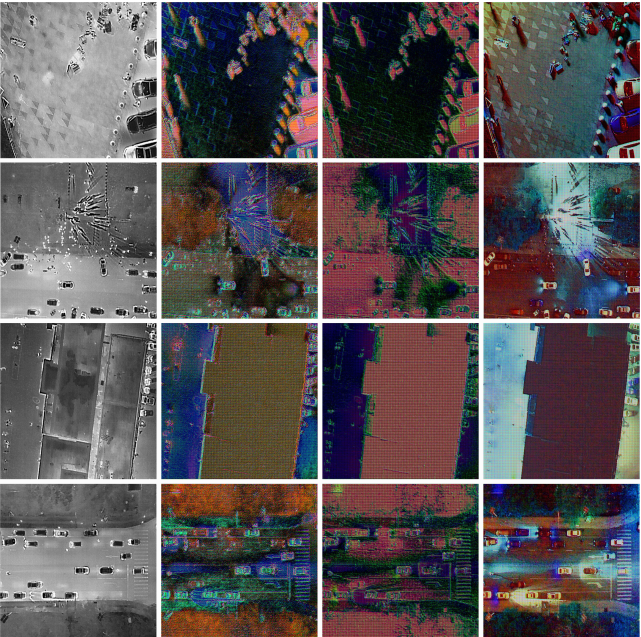
Figure 10. Samples of the four GAN models. From left to right are the infrared images, images generated by GAN, images generated by detection task oriented GAN and images generated by GAN with detection features